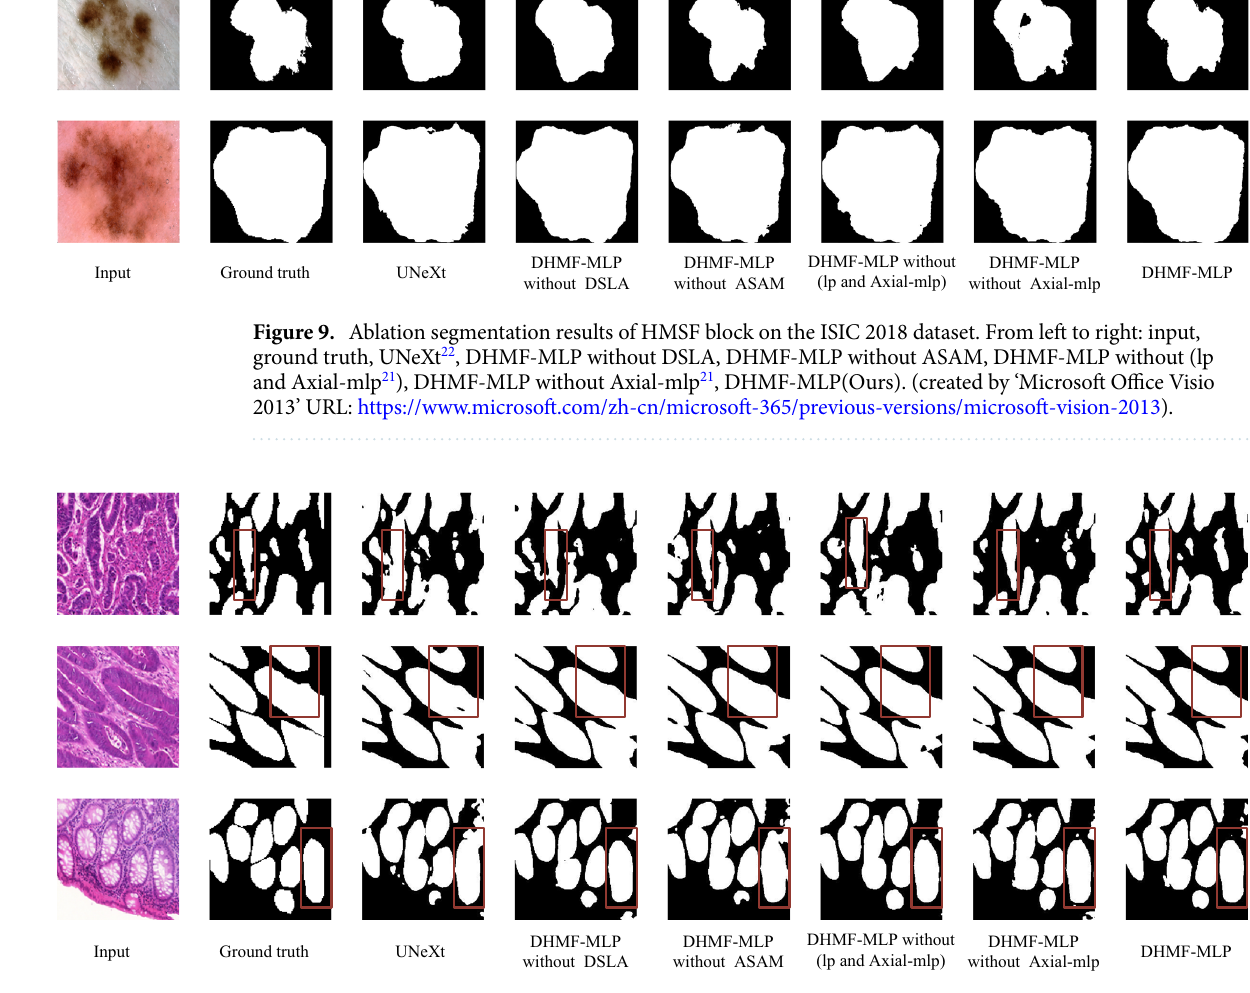
Figure 10. Ablation segmentation results of HMSF block on the GlaS dataset. From left to right: input, ground truth, UNeXt 22 , DHMF-MLP without DSLA, DHMF-MLP without ASAM, DHMF-MLP without (lp and Axial- mlp 21 ), DHMF-MLP without Axial-mlp 21 , DHMF-MLP(Ours). (created by ‘Microsoft Office Visio 2013’ URL: https:// www. micro soft. com/ zh- cn/ micro soft- 365/ previ ous- versi ons/ micro soft- vision-